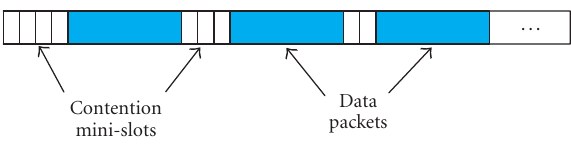
Figure 3: CSMA-based random